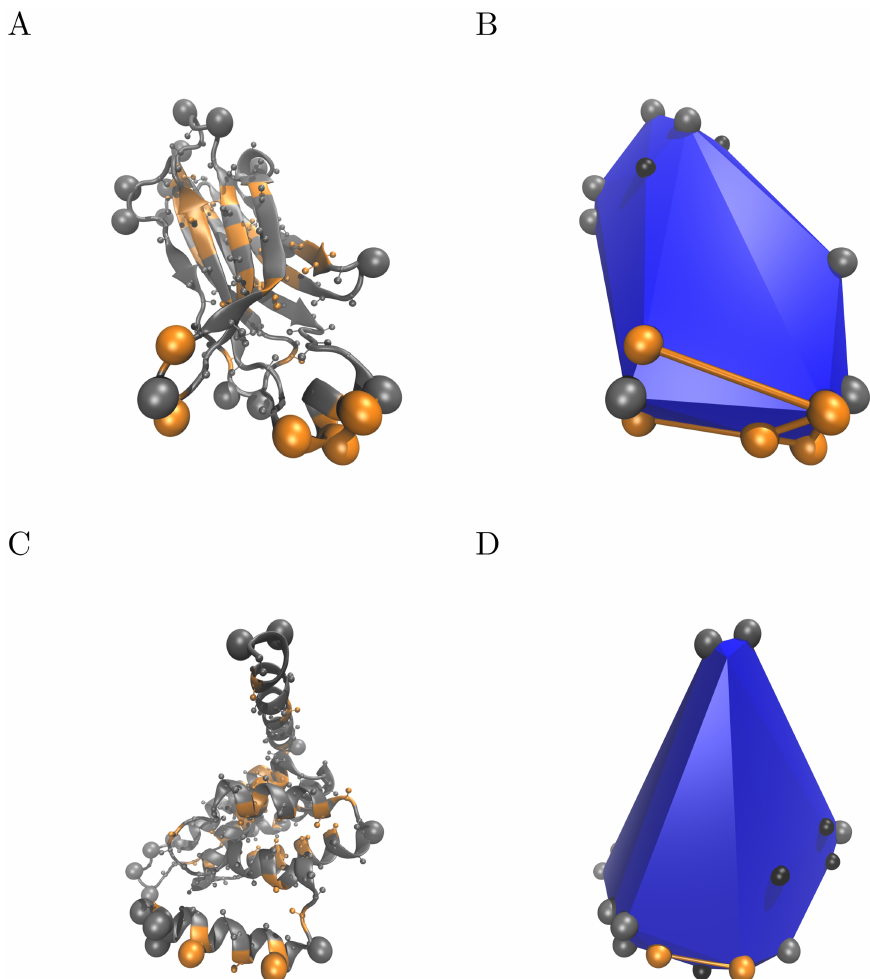
Fig 1. The definitions of ‘protrusions’ and ‘co-insertable protruding hydrophobes’. Panel A shows a cartoon representation of the C2 domain of human phospholipase A 2 (PDB ID: 1RLW), and panel B shows the convex hull for the same protein. Panel C shows the structure of the ENTH-domain (PDB ID: 1H0A), which contains an amphipatic helix. The corresponding convex hull is shown on panel D. All C α - and C β -atoms are shown as spheres. Hydrophobes are coloured orange. The convex hull for the C α - and C β -atomic coordinates is shown in blue. All spheres visible on the convex hull representation are vertex residues. ‘Protrusions’ are defined as vertex residues with low local protein density, and shown as large grey spheres. ‘Co-insertable protruding hydrophobes’ are protruding hydrophobes that are adjacent vertices of the convex hull and are shown connected by orange lines. Small black spheres are at vertex residues that have high local density, and do therefore not meet the criteria for